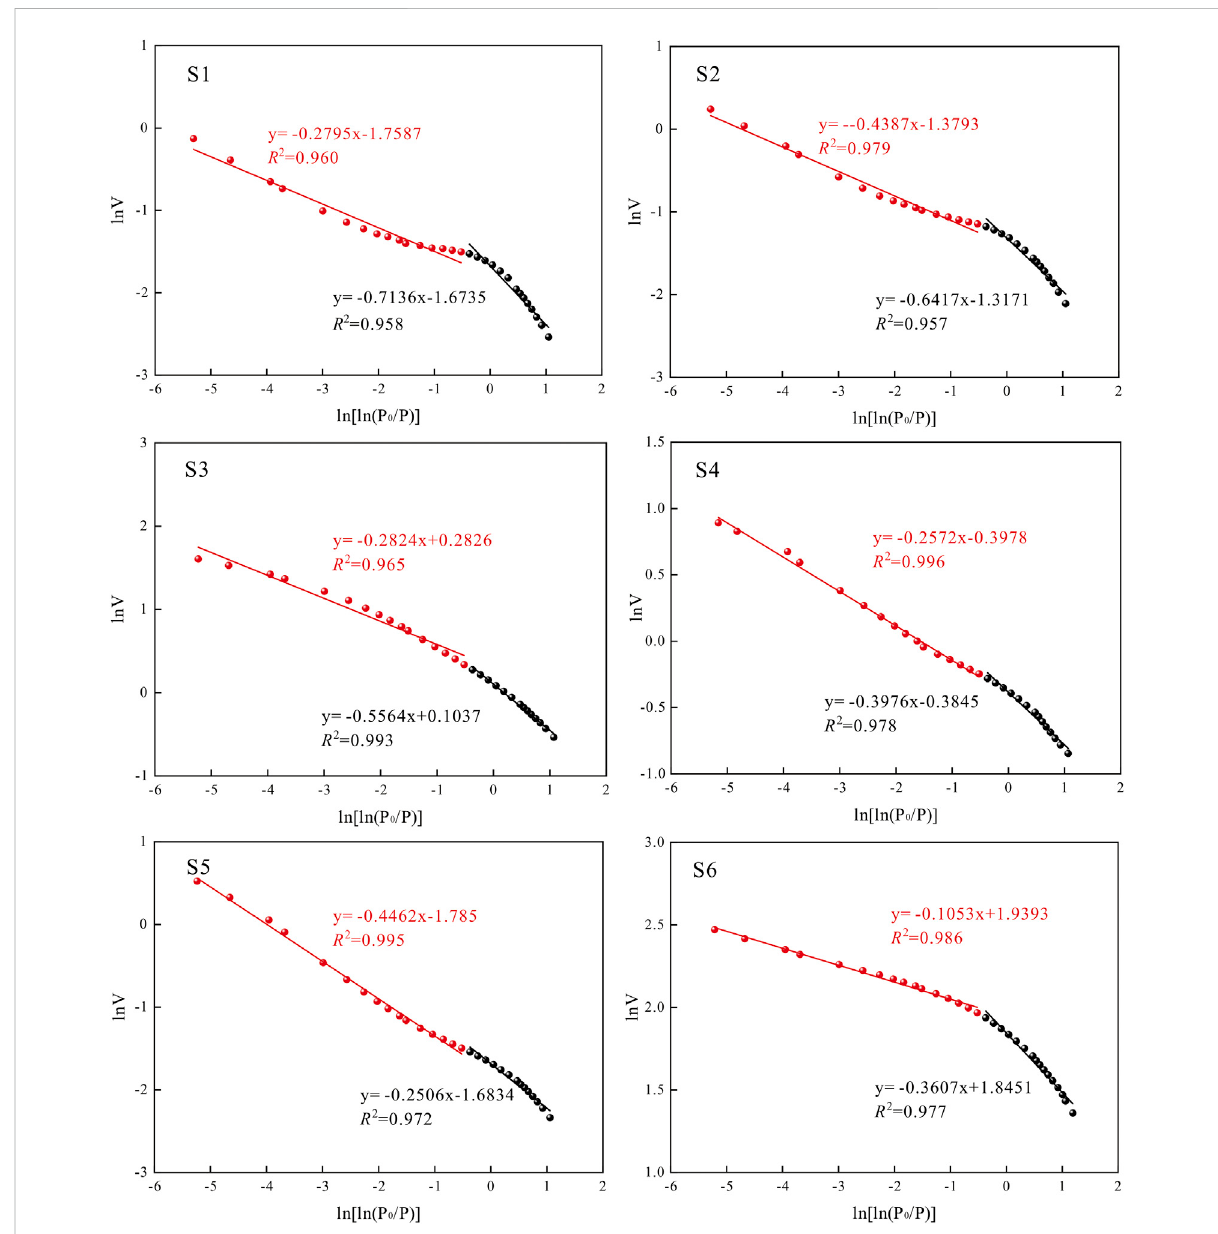
FIGURE 6 Scatterplots of ln V vs. ln (ln ( P 0 / P )) for six shales by LT-N 2 GA